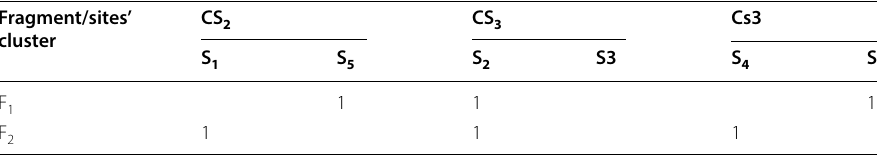
Table 16 Scenario (1)—final allocation